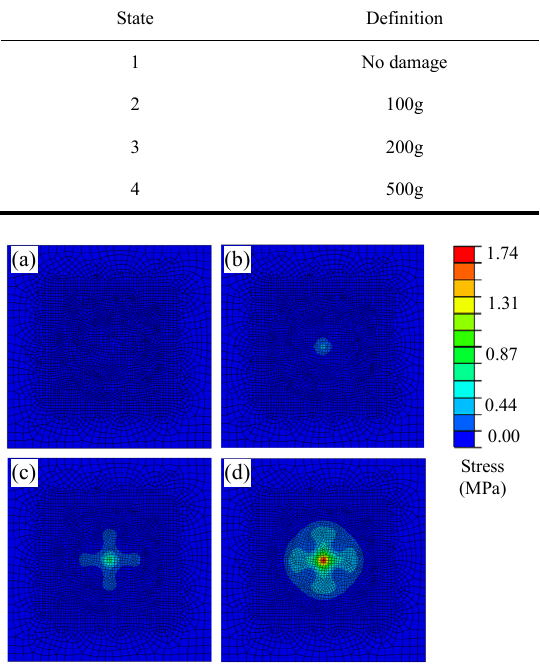
Fig. 4 Stress cloud charts of (a) ‒ (d): damage states 1 ‒ 4.